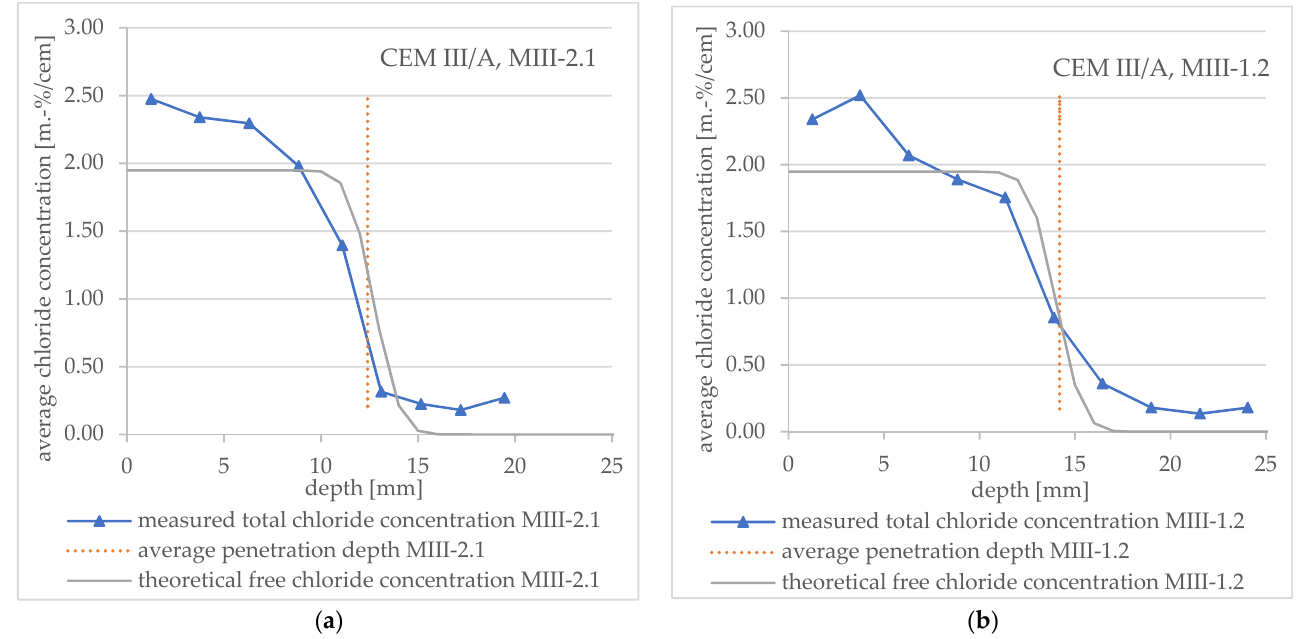
Figure 12. Total chloride concentration profiles measured after an RCM test including average penetration depth (vertical lines) measured after spraying AgNO 3 and theoretical profile ( a ) for CEM III/A mortar specimen no. MIII-2.1 and ( b ) for CEM III/A mortar specimen no. MIII-1.2.